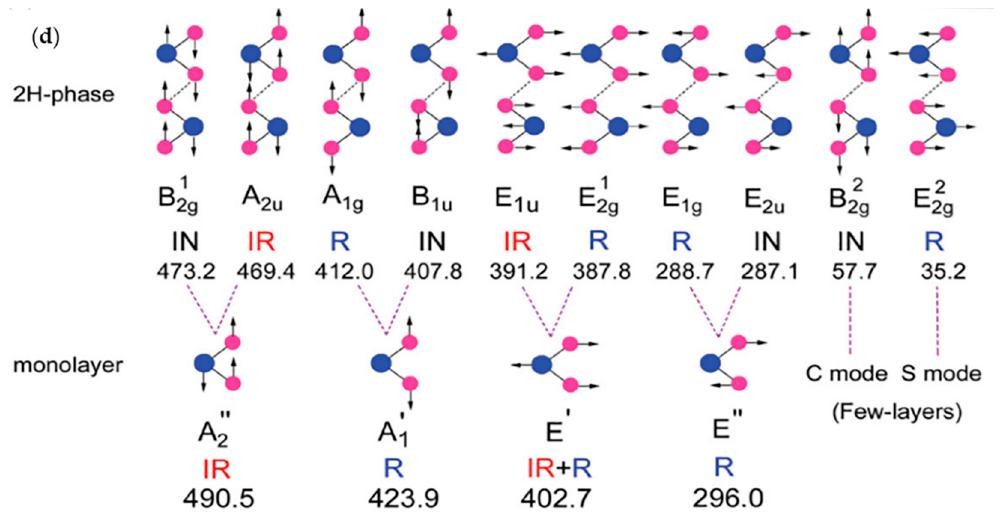
Figure 4. Raman spectroscopy and its production principle. ( a ) Illustration of the incident light (the green line) on a sample surface producing fluorescence (the gray line) and light scattering including Rayleigh scattering (the purple line), anti-Stokes Raman scattering (the blue line), and Stokes Raman scattering (the red line). Reproduced with permission from [96]. Copyright 2016, Nature Publishing Group. ( b ) Diagram of energetic transitions involved in Raman scattering. Top and bottom of the diagram are vibration energy levels, and the middle is virtual energy levels, respectively. Raman scattering is inelastic scattering produced by energy level transition of electrons excited by incident photons, which is divided into Stokes Raman scattering (the red icon) and anti-Stokes Raman scattering (the green icon) differencing from Rayleigh scattering (the black icon). In Stokes Raman scattering, the incident photon is higher frequency than the scattered photon, meaning that the incident photon has more energy, while in anti-Stokes scattering, the incident photon is of lower energy. ( c ) Typical setup of instrumentation within a spontaneous micro-Raman spectroscopic system. An incident light (represented by the blue line) emitted by laser source, passing through the band pass filter and the dichroic mirror, hits on the sample through the optical microscopy system. Then, the scattering light (represented by the green line) from the sample passes through the reflected mirror, dichroic mirror, and long pass filter in sequence, after that the light is dispersed by the spectrometer, collected by the detector finally. Reproduced with permission from Ref. [97]. Copyright 2017, Nature Publishing Group. ( d ) Optical vibration modes of 2H-MoS 2 and monolayer MoS 2 . TMD (MX 2 ) have three polytypes according to their lattice structure, including 1T-, 2H-, and 3R-polytype. Here the model diagram of 2H-polytype is presented, in which the lattice vibrational mode A 1 g corresponds to the out-of-plane relative motion of X atoms and E 2g corresponds to the in-plane opposing motion of M and X atoms. A 1g and E 2g of Raman spectrum are presented in the following diagram. Reproduced with permission from Ref. [98]. Copyright 2014, American Physical Society. ( e ) The Raman spectrum of single (solid red line) and few (more than 10) layers (dash blue line) MoSe 2 /MoS 2 . It can be clearly seen that both A